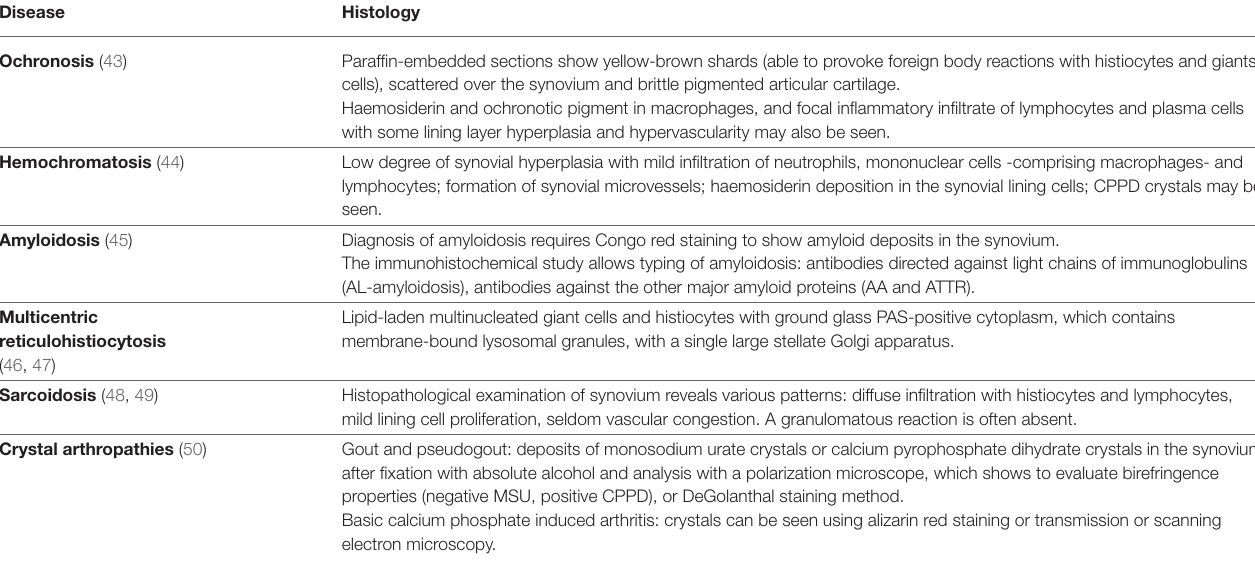
TABLE 3 | Main non-infectious etiologies for refractory mono- or poly-arthritis: WHAT do you find?